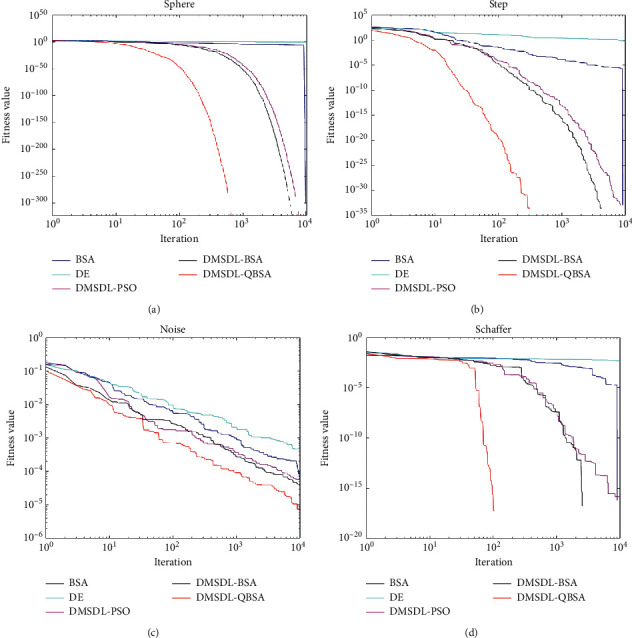
Fitness value curves of 5 hybrid algorithms on (a)f1; (b)f5; (c)f6; and (d)f9 (Dim = 2).